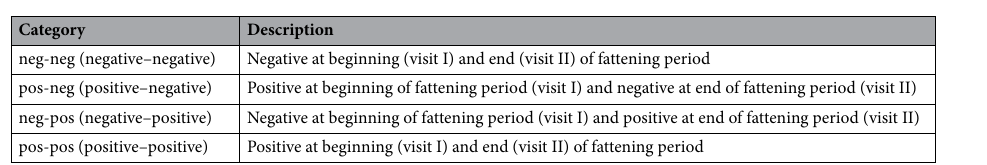
Table 1. Categories of LA-MRSA status of the samples.